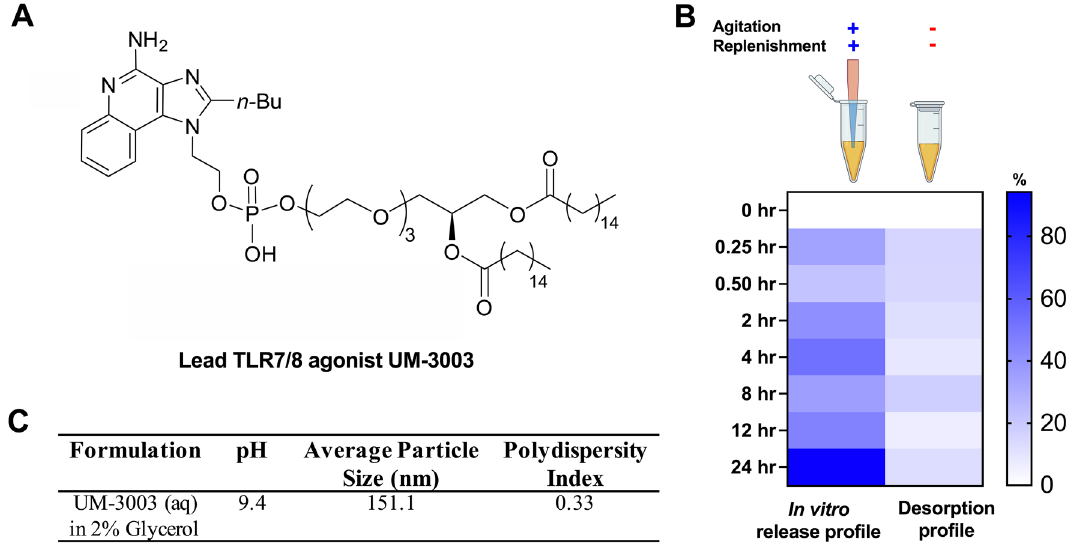
Figure 3. The optimized phospholipidated TLR7/8 agonist UM-3003 rapidly and fully adsorbed onto alum. ( A ) Chemical structure of the lead TLR7/8 agonist UM-3003. The phosphorylated derivative of the IMQ UM-3001 was modified through introduction of a polyethylene glycol (PEG) linker of 3 repeating units generating a compound that was named UM-3003. ( B ) In vitro release and desorption profile of UM-3003 from UM-3003 alhydrogel adsorbed formulation in adjuvant free human plasma. Percentage desorption is distributed to scale from 0 to 100. ( C ) Average particle size, pH and polydispersity index of UM-3003 in 2%